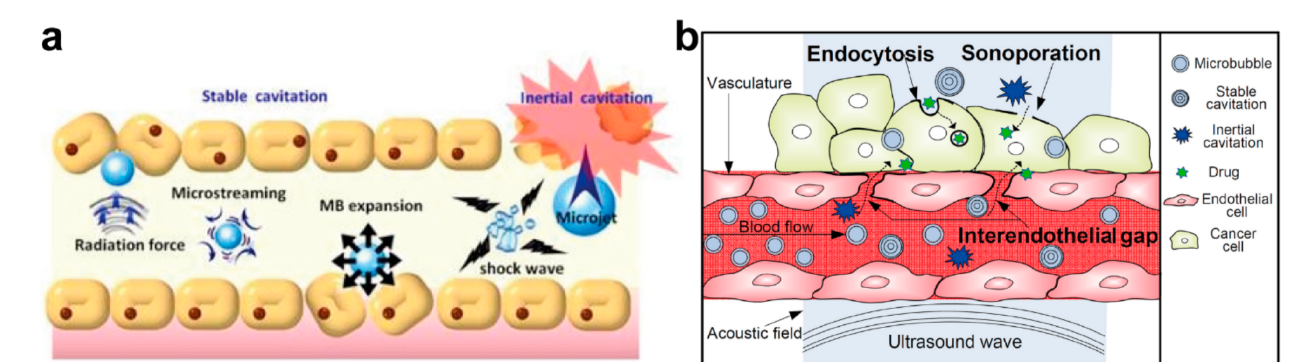
Figure 6. ( a ) Physical mechanisms of stable and inertial cavitation underlying the enhanced vessel permeability and triggering the drug release. Reproduced with permission from [133]. Copyright 2021, Ivyspring International Publisher. ( b ) Overview of the three main passive and active delivery routes enhanced by ultrasound-driven microbubbles. Sono- poration, which refers to transient and reversible membrane perforation by acoustic cavitation, allows macromolecules to passively diffuse into the cell. The interendothelial gap, which refers to the alteration of vascular integrity and the opening of the interendothelial junction by acoustic cavitation, provides an active route for macromolecule delivery into the extravascular tissues. Endocytosis enhanced by stable cavitation can actively deliver the macromolecules into the cell via vesicles. Reproduced with permission from [131]. Copyright 2018, Elsevier